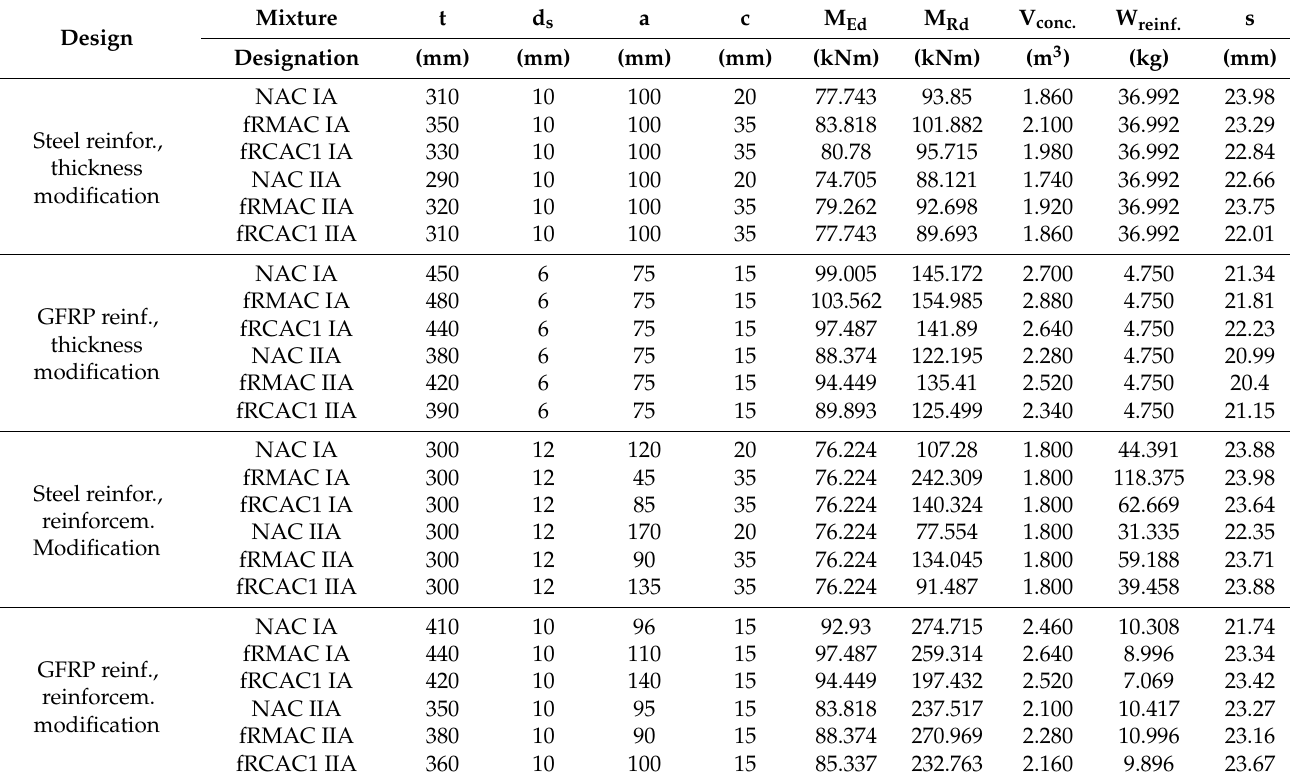
Table 6. Limit states of serviceability, results of design, and